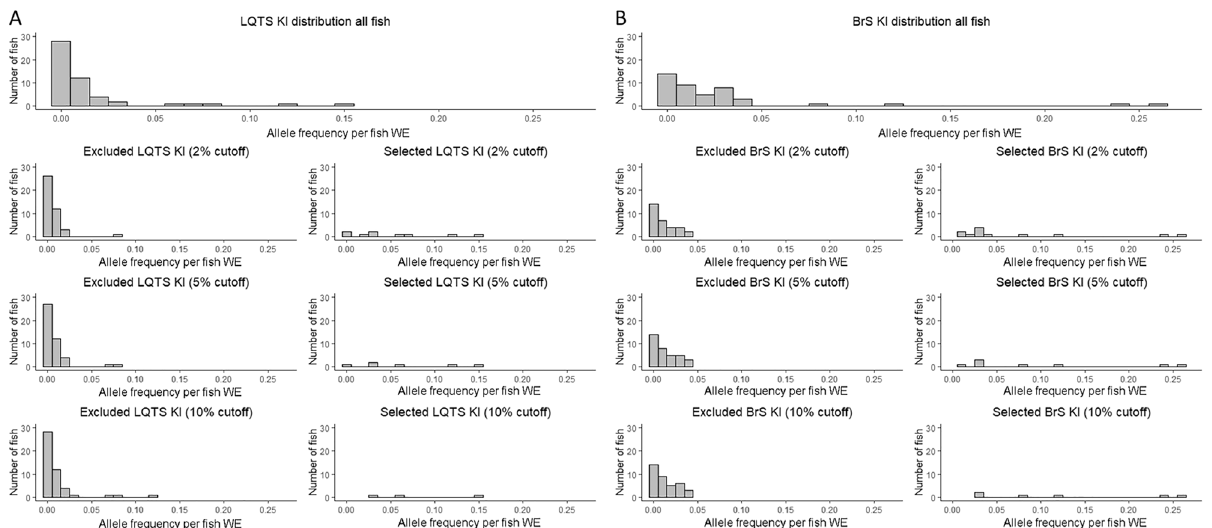
Figure 5. Zebrafish embryo genotyper-based knock-in selection. Histogram of distributions of KI counts of all fish (before selection) and excluded and selected fish after selection with ZEG at 2%, 5% and 10% threshold at the LQTS (n = 51) ( A ) and BrS (n = 43) ( B ) locus. WE whole embryo, KI knock-in, indel insertion/deletion.